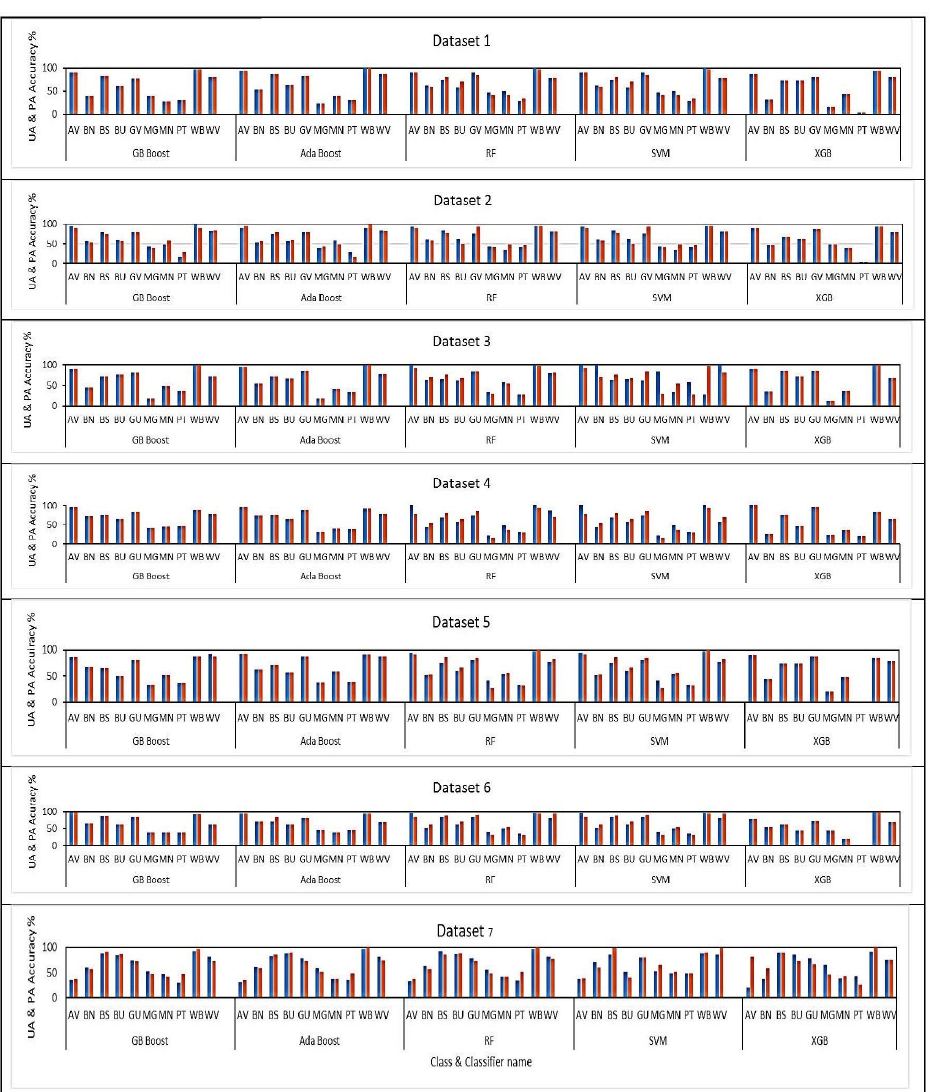
Figure 8. User’s (blue) and producer’s (red) accuracy per class produced using GB, Ada Boost, XGBoost, RF, and the SVM classifier. On each classifier, there is a trade ‐ off between the user and producer accuracy across the datasets.